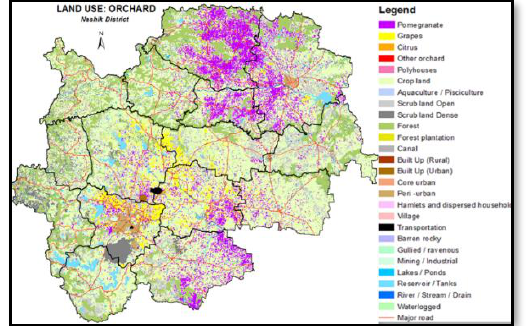
Figure 11. Mapping of Pomegranate, Grapes, Citrus on Land use map in Nashik,